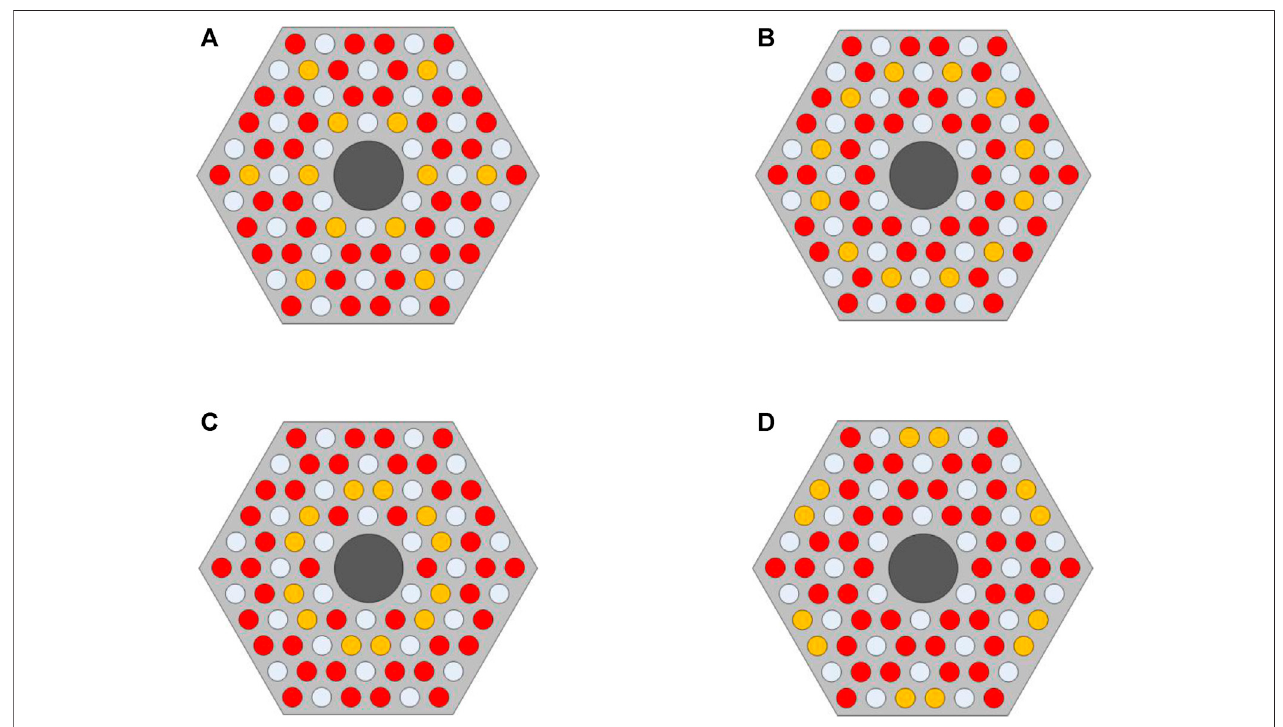
FIGURE 9 | Arrangements of 12 YH 1.8 solid moderator rods.